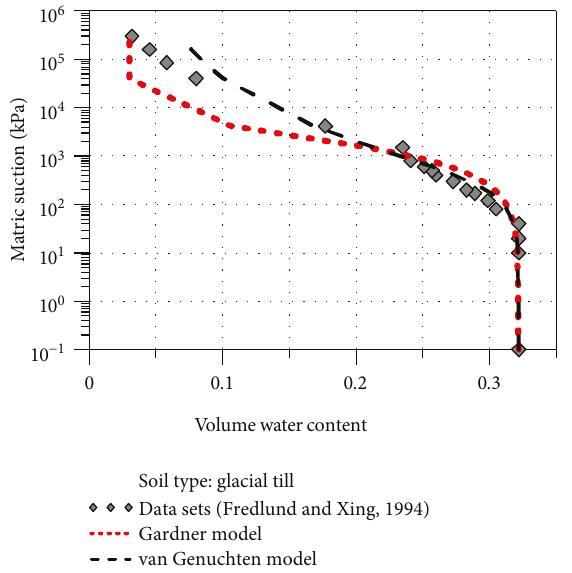
Figure 12: Fitting results of the SWCC using van Genuchten and Gardner